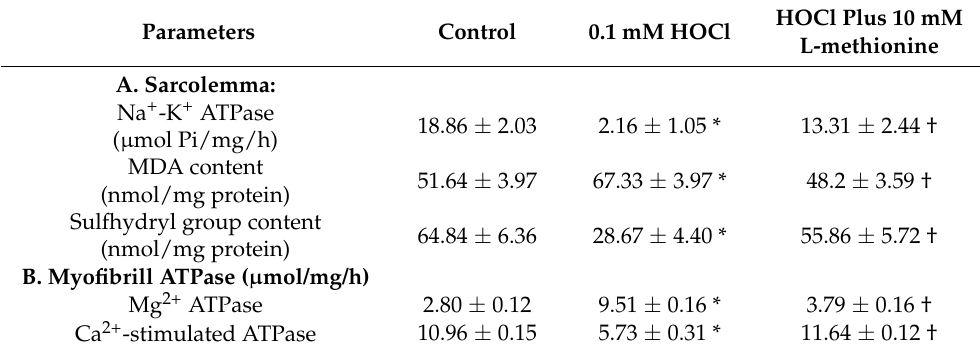
Table 5. Modification of ATPase activities in cardiac sarcolemma and myofibrils upon incubation with HOCl for 30 min in the presence or absence of